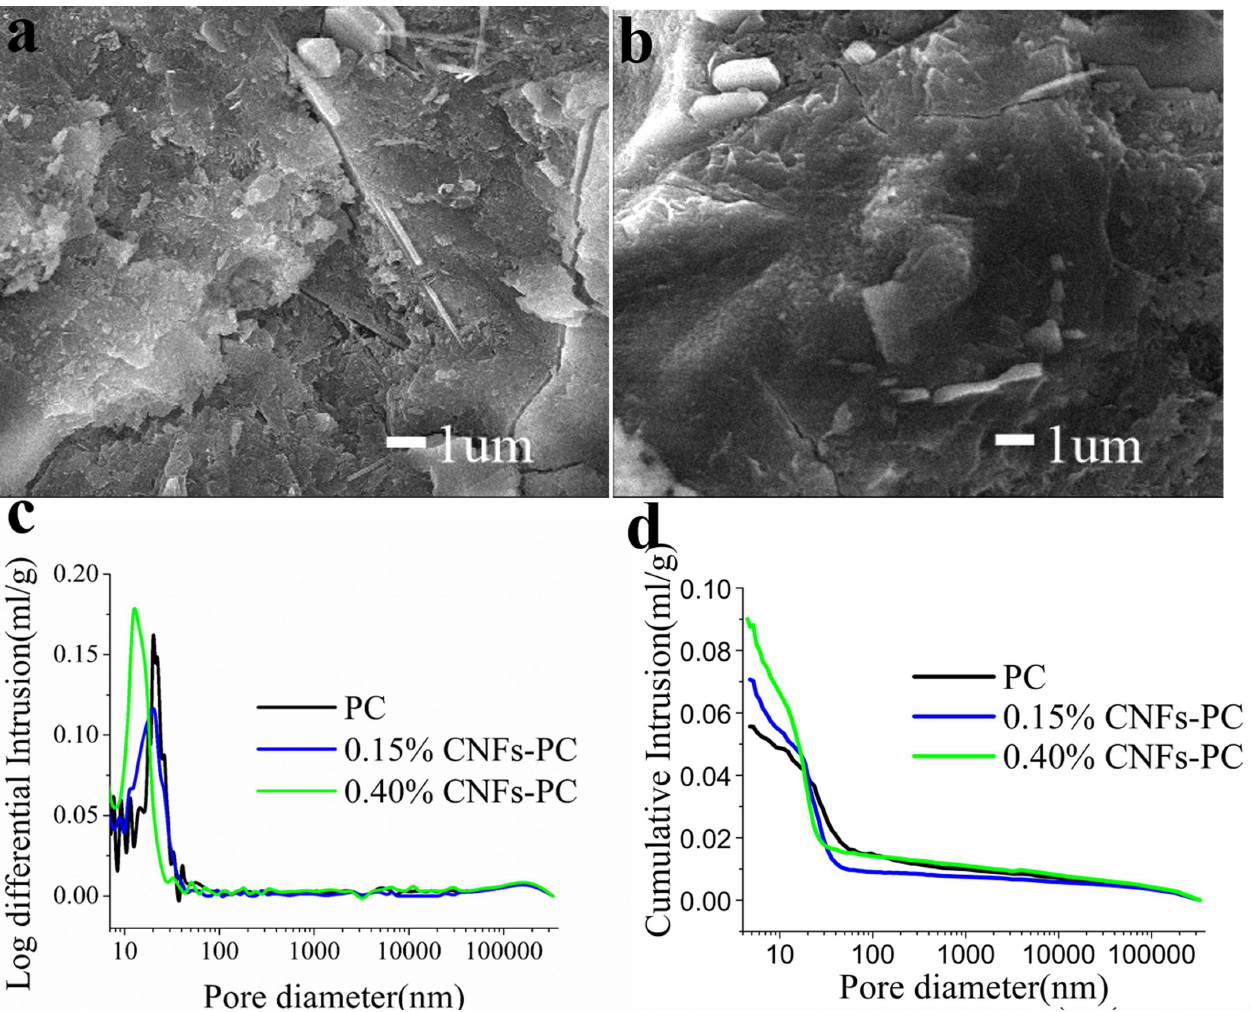
Fig 5. The microstructure of cement pastes after aging 28 days. (a) SEM image of the cement paste. (b) SEM image of cement paste with 0.15% of CNFs; (c) and (d) Pore diameter distributions of cement pastes with different CNF content.